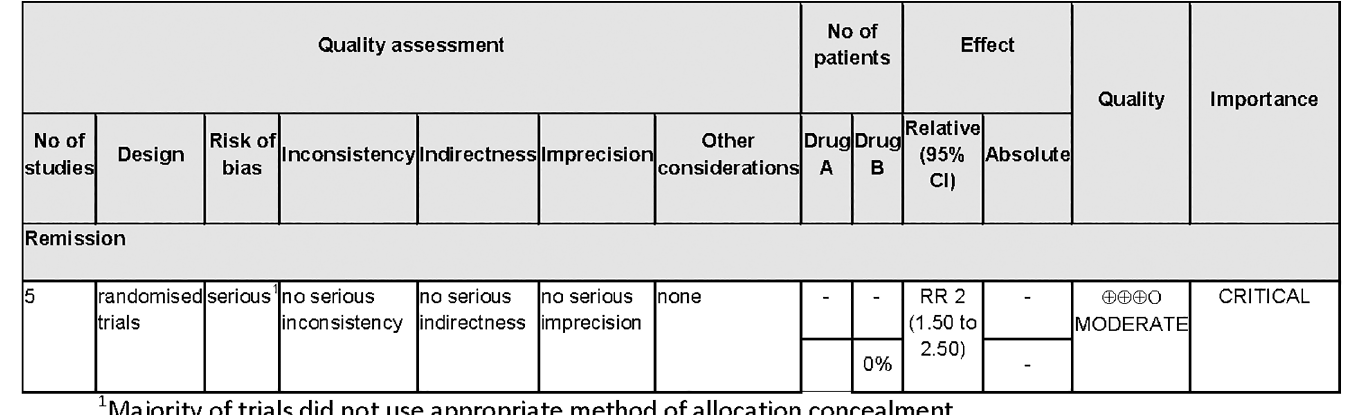
Fig 1. Example evidence profile using